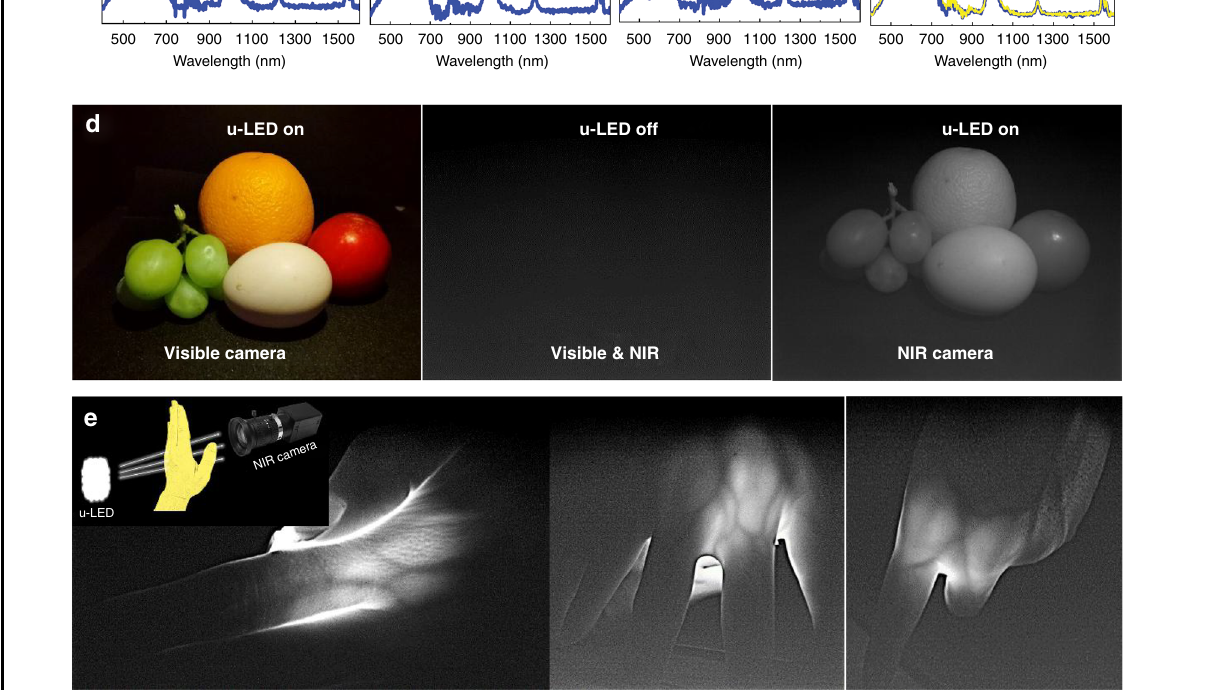
Fig. 5 Application demonstration of Bi/Ln:DP-based ultrabroadband LED. a Schematic diagram of the experimental setup for measuring absorption. PL spectra with and without the measured substance inside the integrated sphere using u-LED as the light source: ( b ) water and EtOH, ( c ) plum, tomato, grape, and eggs. Δ PL is de fi ned as PL(u-LED) - PL(u-LED + substance). d Photos of fruits with and without u-LED irradiation recorded by visible and NIR cameras. e Photos of palm and fi nger after transillumination of NIR light from